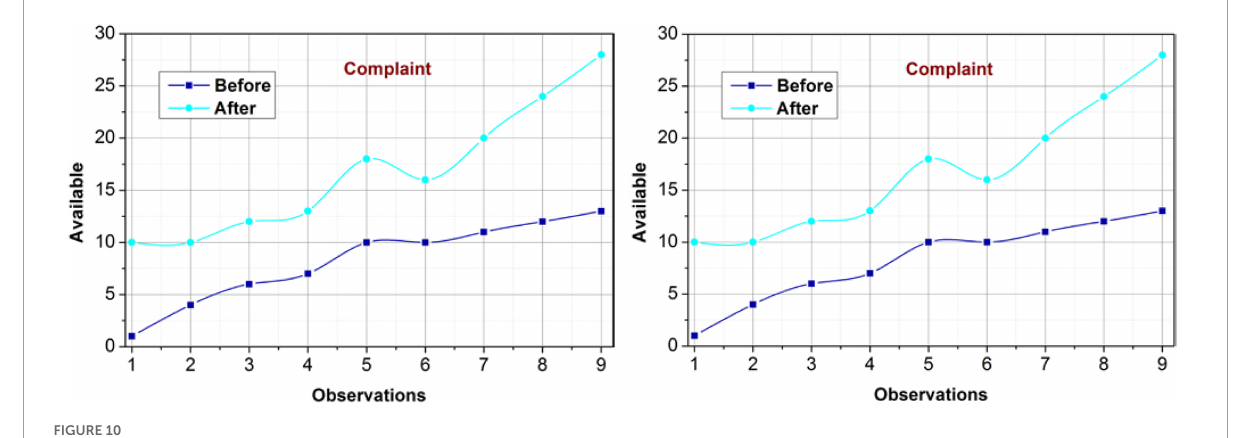
FIGURE10 Availability and dissimilarity (complaint).